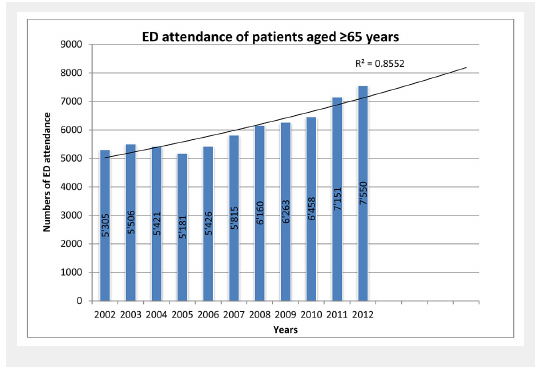
Trend of emergency department (ED) visits by patients aged 65 years and over. The development of the ED attendance of patients ≥65 years between 2002 and 2012 is provided. The line represents the trend of an exponential regression with the calculated coefficient R 2 = 0.8552 of the ED attendance of this patient group based on the existing data. It is probable that the patients ≥65 years will continue to grow.